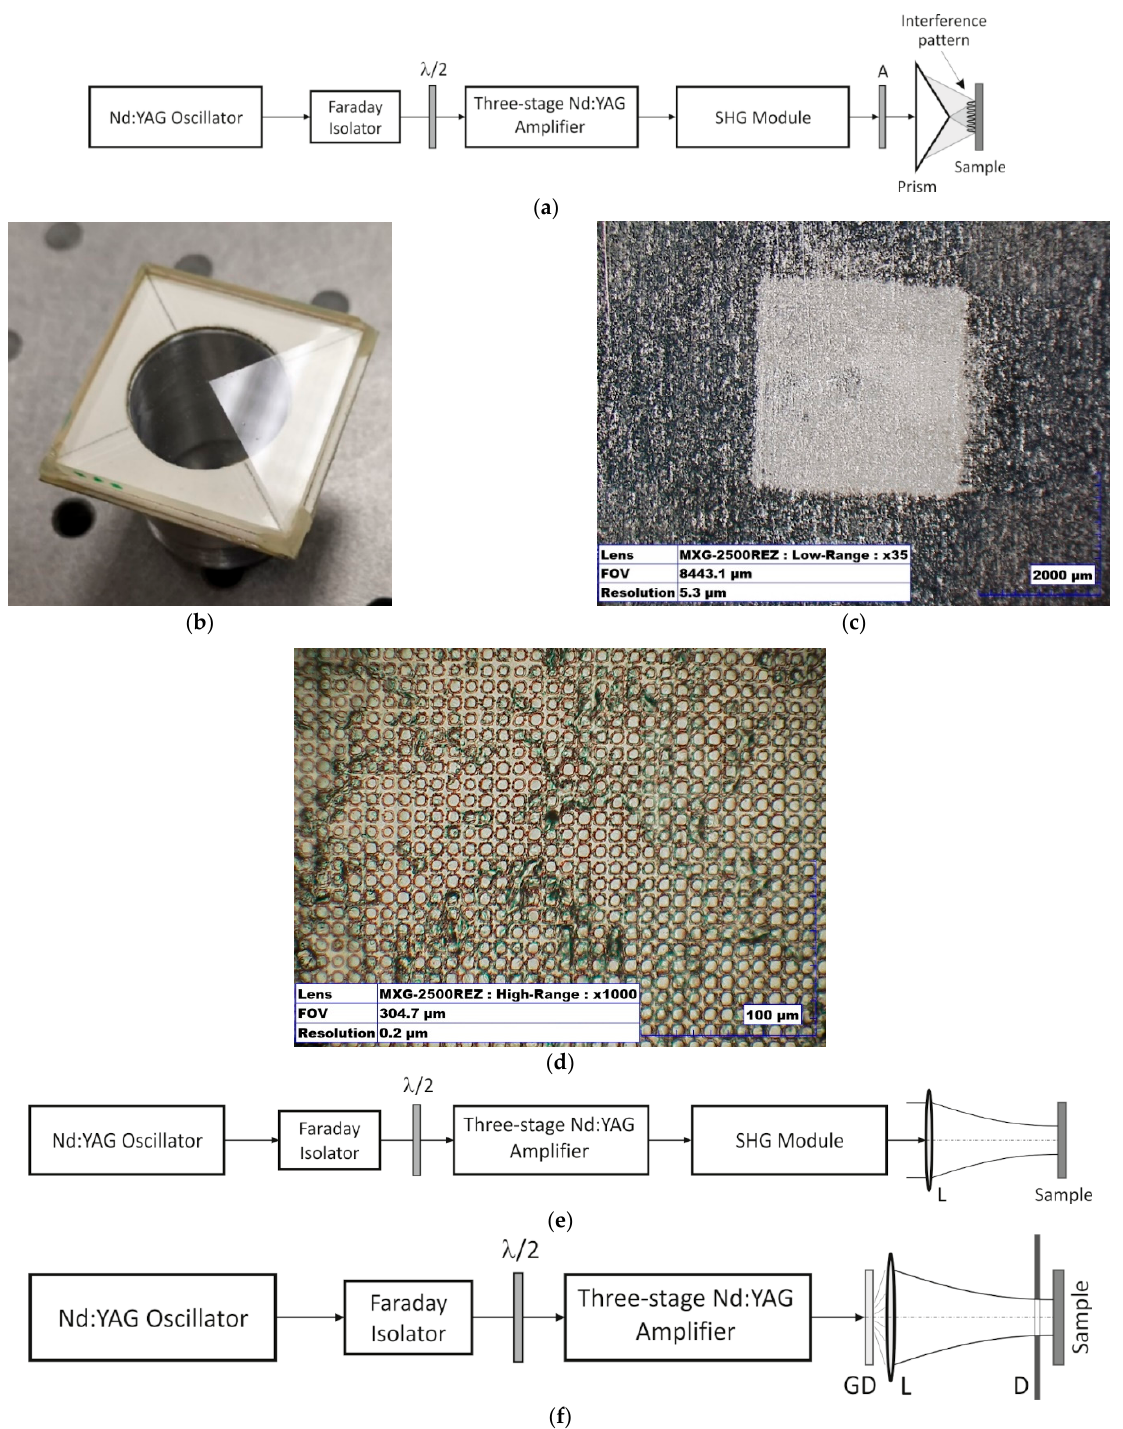
Figure 2. ( a ) Experimental system with prism-based interferometer for tissue acellularisation: A—polarizing attenuator, λ /2—half-wave plate; ( b ) pyramidal prism with a square base; ( c ) micro- scopic images of the square area of interference pattern ( × 35); ( d ) its central part at higher magnifi- cation ( × 1000); ( e ) experimental setup: λ /2—half-wave plate, A—polarizing attenuator, L—focus- ing lens; and ( f ) Experimental setup: M—totally reflecting mirrors, λ /2—half-wave plate, D—dia- phragm, GD—glass diffuser, and L—focusing lens.